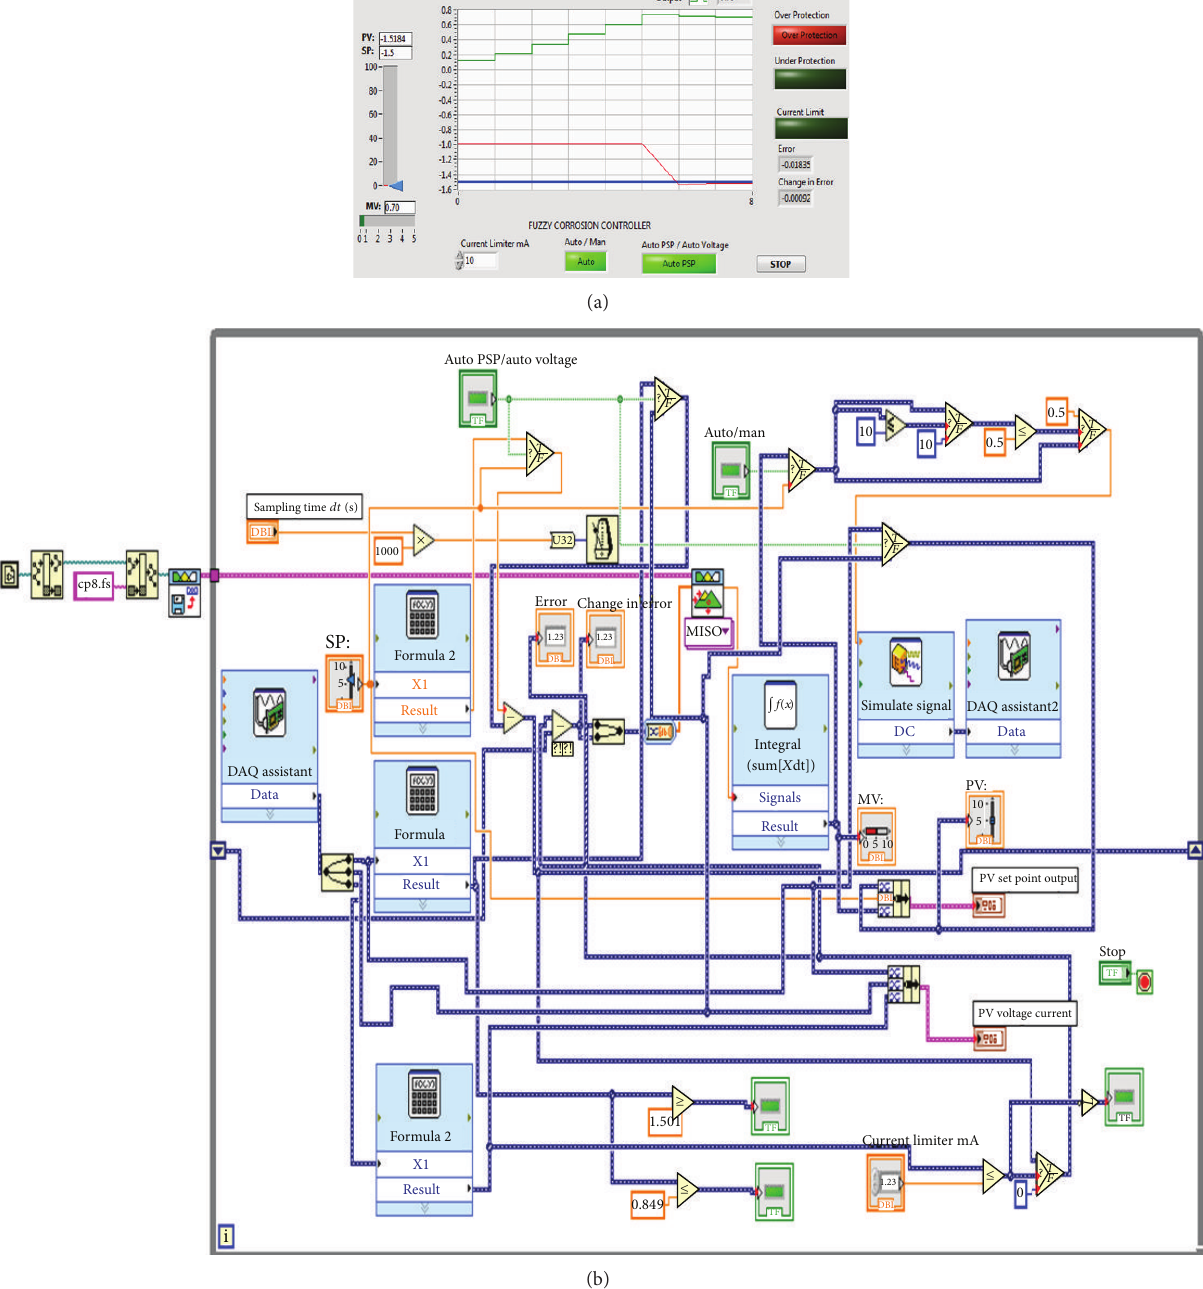
Figure 5: (a) Front panel of VI fuzzy incremental corrosion controller. (b) Block diagram of VI based fuzzy incremental corrosion controller.